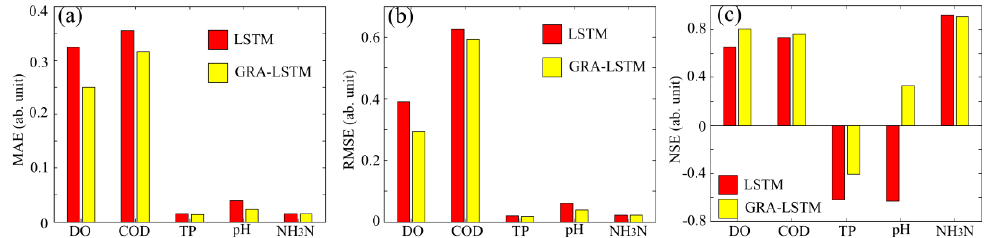
Figure 7. Error analyses using LSTM and GRA-LSTM methods. ( a ) MAE comparisons; ( b ) RMSE comparisons; ( c ) NSE